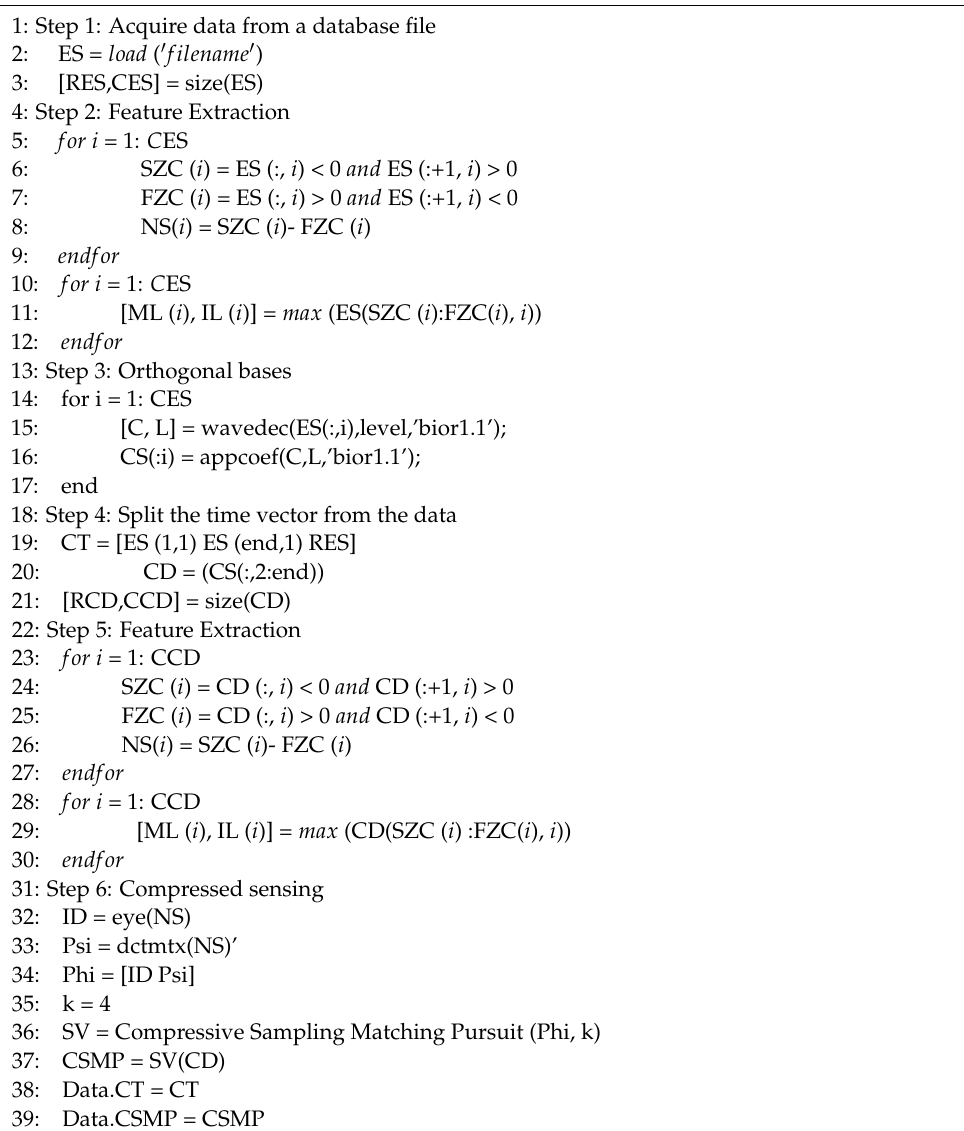
Algorithm 1 Feature extraction and orthogonal